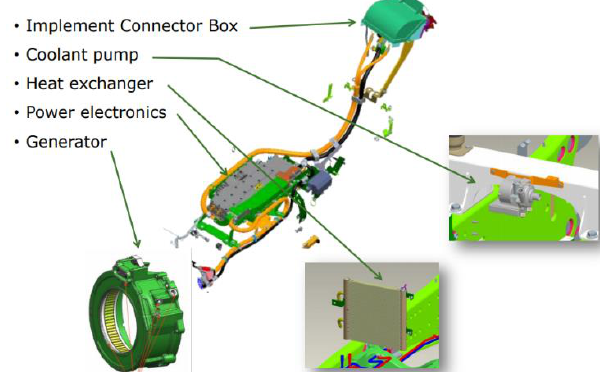
Fig. 16. John Deere 6210 RE powertrain components [30] Similar solution was presented by Fendt in 2013 with model X Concept (Fig. 17) based on conventional Fendt 722 Vario with 147 kW diesel engine. Fendt has integrated AC generator o 130 kW, 700 V DC on the engine output supplying power to the engine auxiliaries: radiator fan and coolant pump and to the external sockets available to power implements [15,